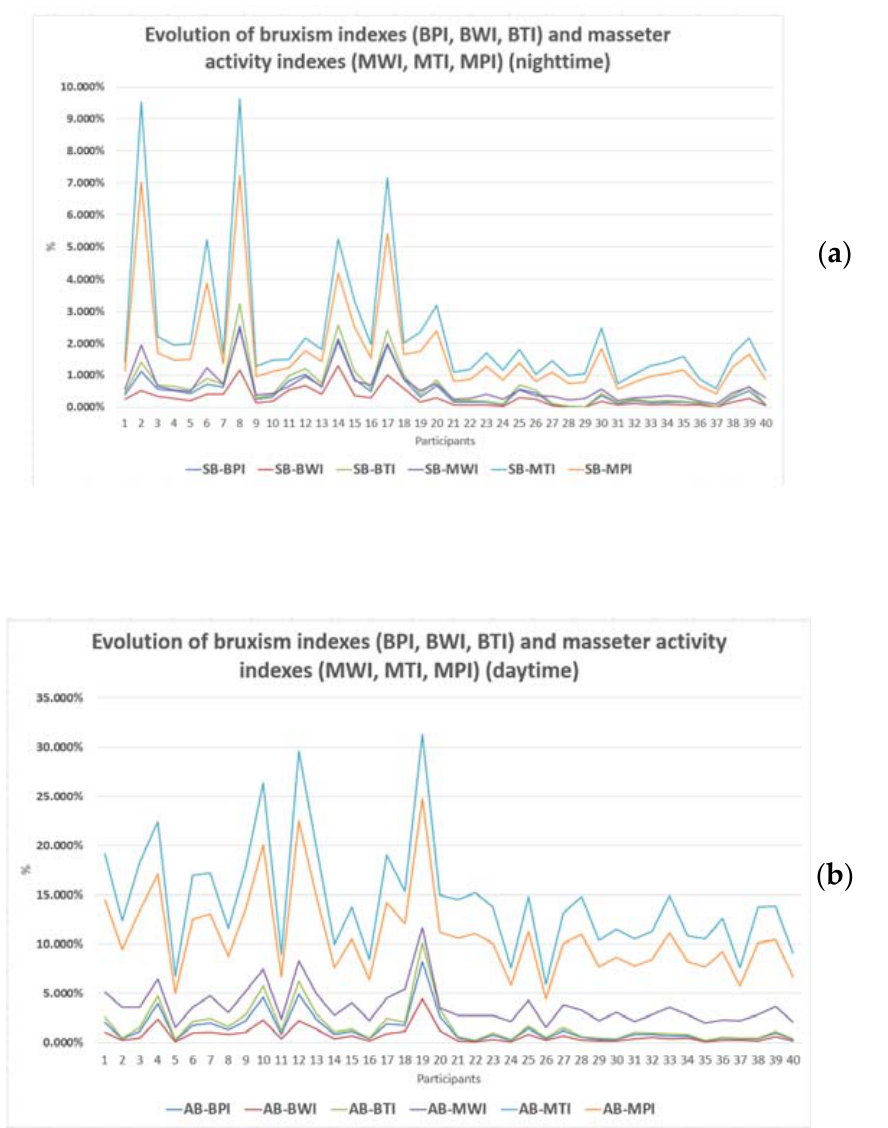
Figure 5. Evolution of the values of the indices for bruxism and for the activity of the masseter muscle: ( a ) sleep state and ( b ) awake state.